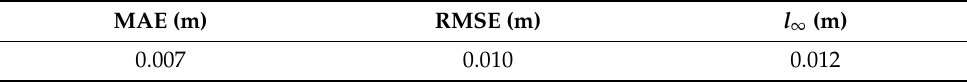
Table 9. Q ̅ for simulation times of 100 and 400 s.